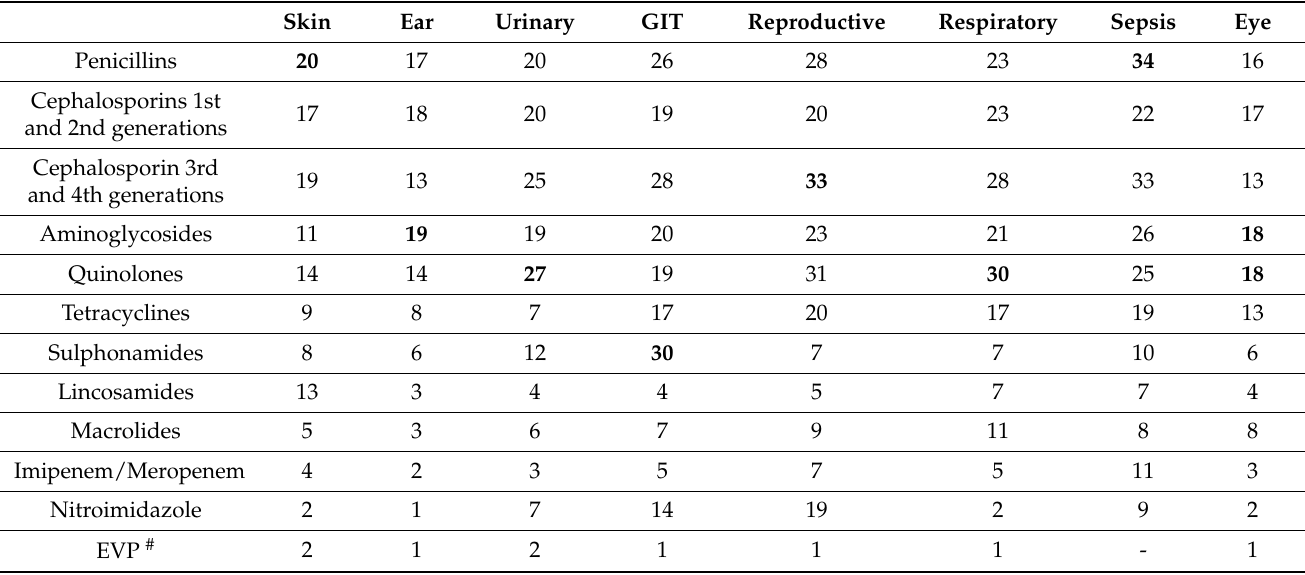
Table 2. Frequency of antimicrobials used by practitioners for different organ systems.